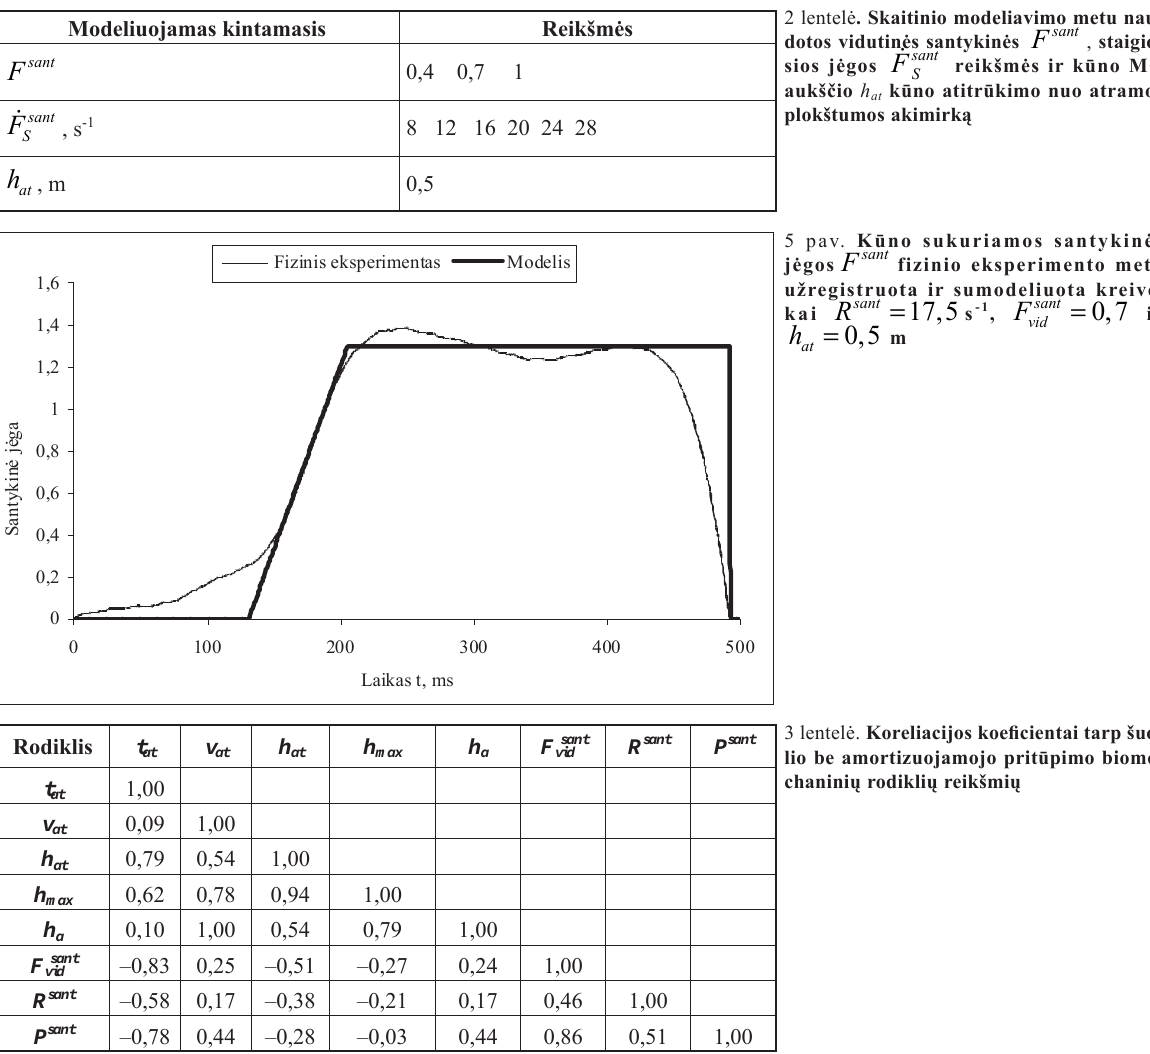
eksperiment ų metu nustatytais duomen ų korelia- ciniais ryšiais (3 lent.): koreliacijos koeficientas tarp santykin ė s šuolio galios P sant ir santykin ė s atsispyrimo j ė gos F vidsant lygus 0,86, o koreliacijos koe fi cientas tarp santykin ė s šuolio galios P sant ir R sant